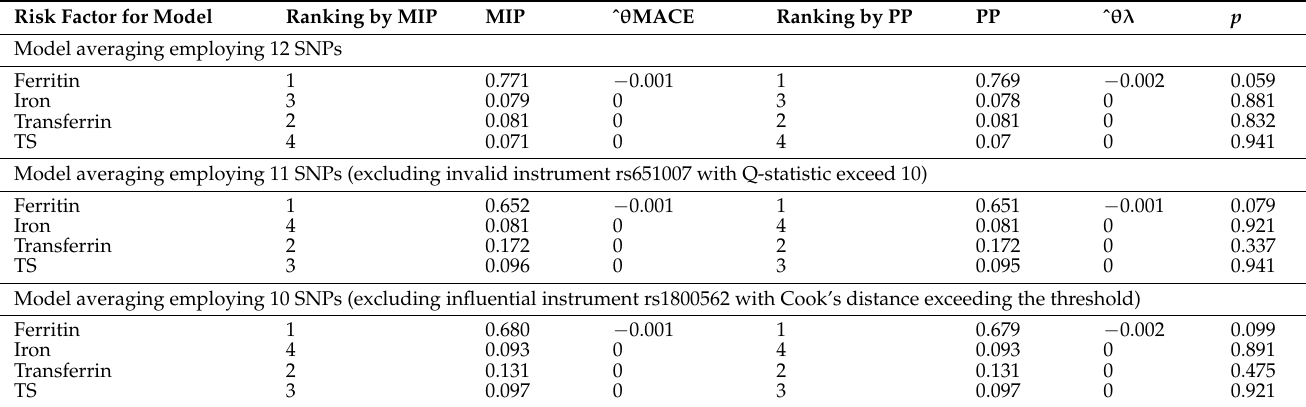
Table 2. Evaluation of the causal link between iron status biomarkers and HF applying MR-BMA # . Risk Factor for Model